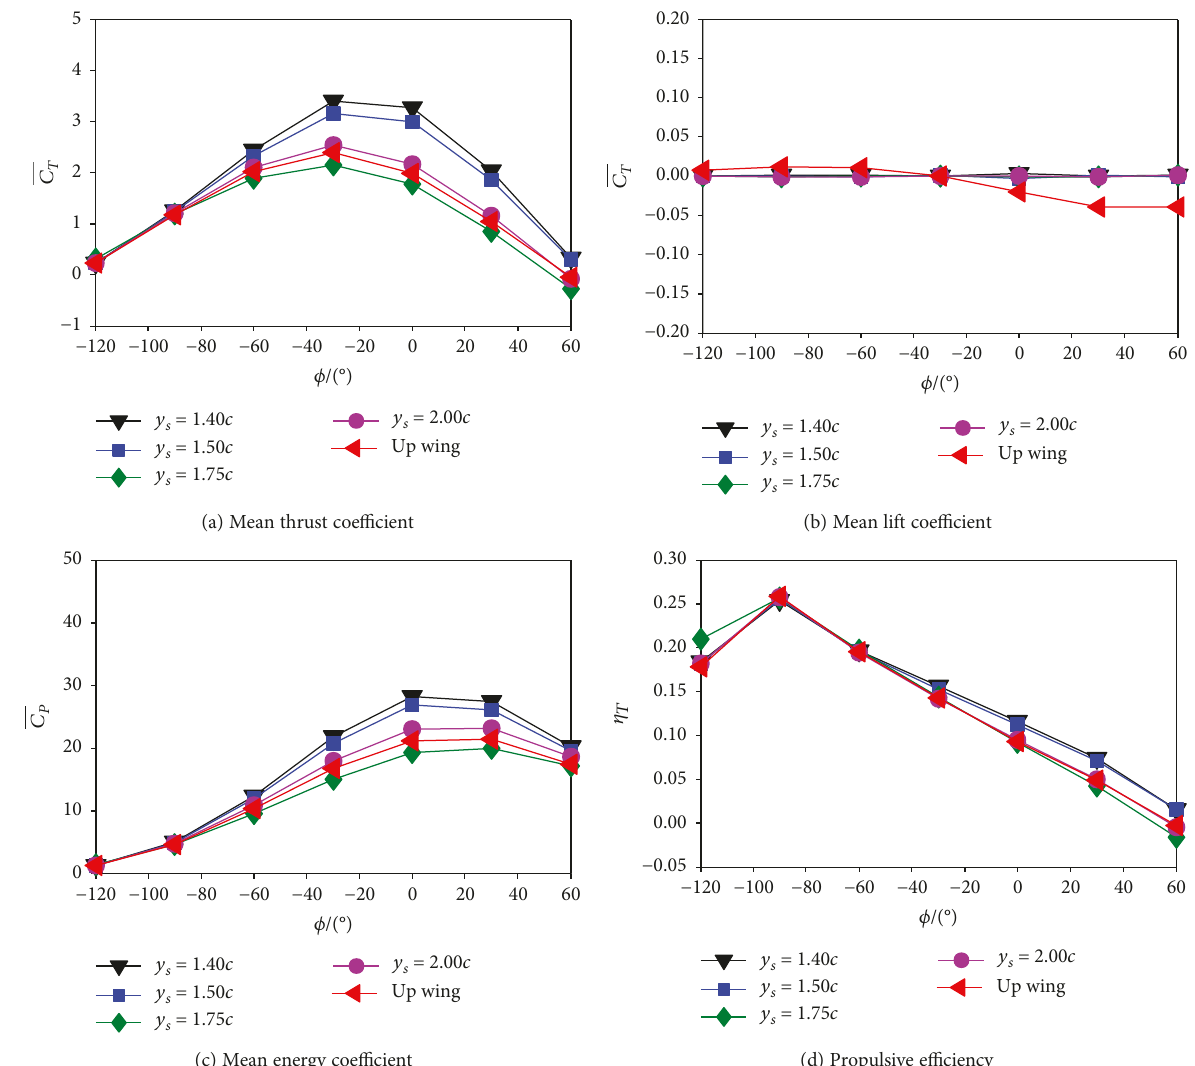
Figure 10: The performance of the biplane counter- fl apping wing with di ff erent mean wing spacing y